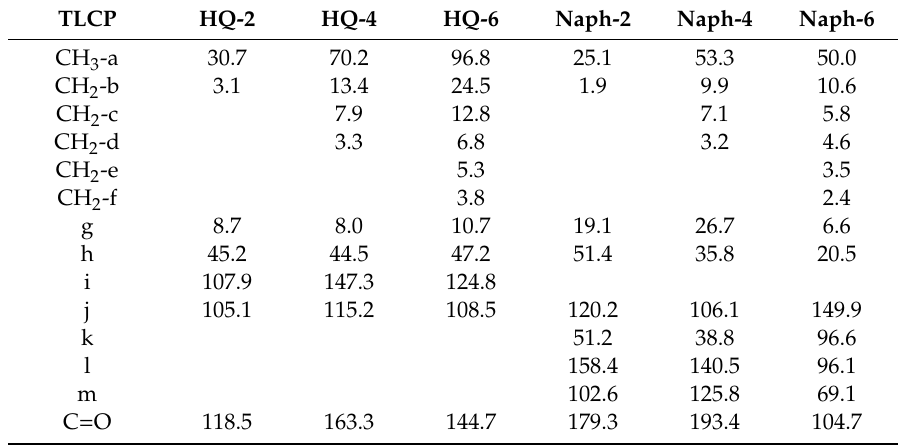
Table 3. Spin-lattice relaxation time T 1 ρ (ms) in the rotating frame for each carbon in the TLCPs at room